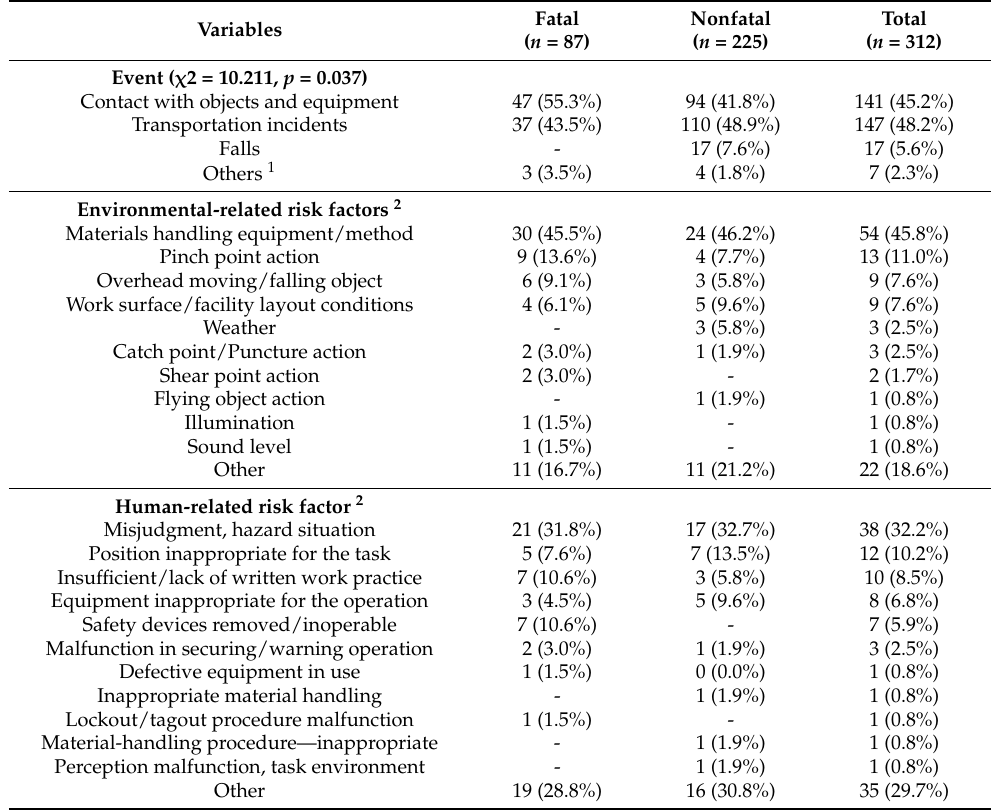
Table 3. The event/exposure, environmental, and human factors.